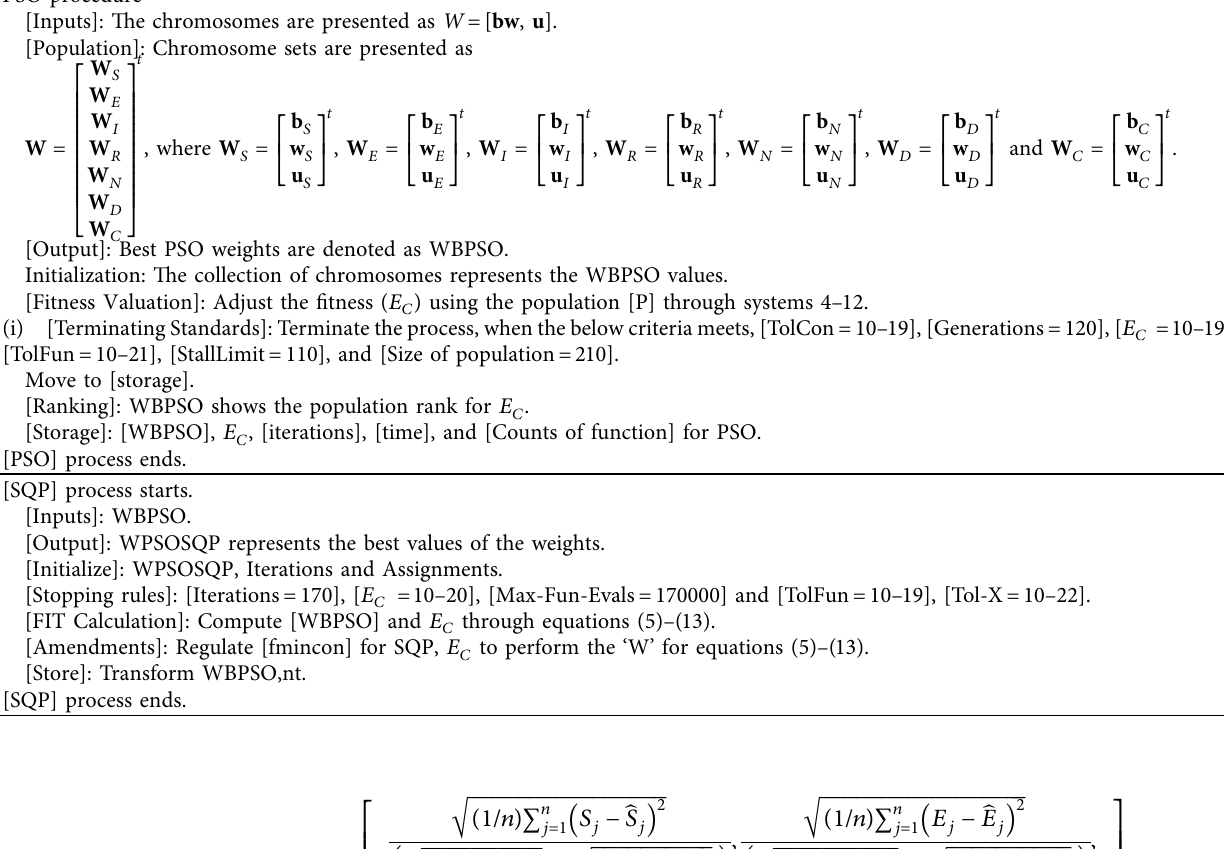
Table 1: Optimization PSOSQP scheme for the mathematical SEIR-NDC system. PSO